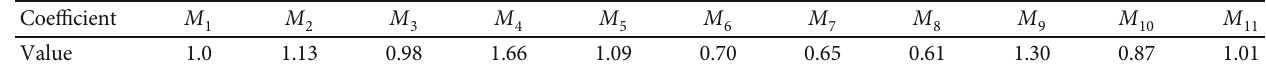
Table 1: Correction coe ffi